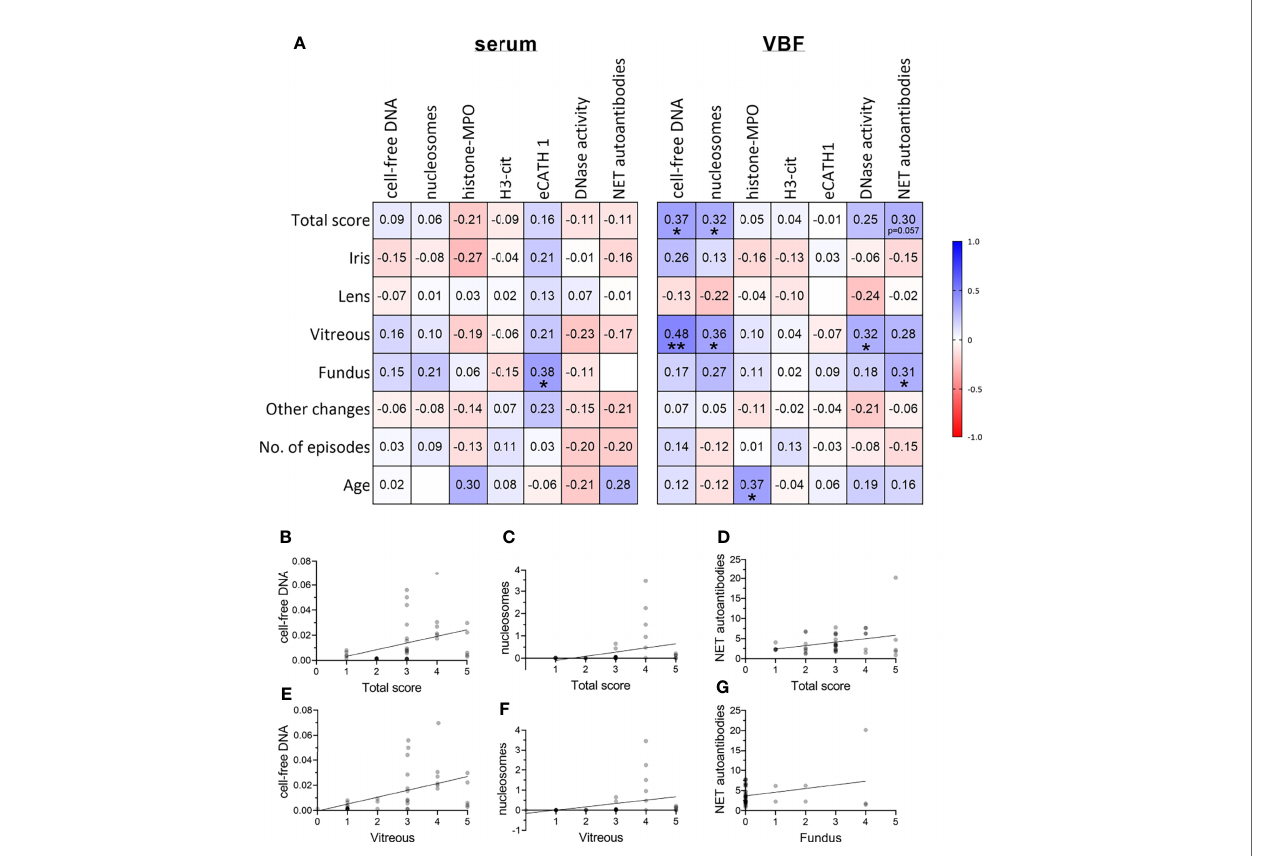
FIGURE 3 | Correlations between severity of ERU and occurrence of NET markers. (A) Correlations between ERU scores and NET markers in sera and vitreous body fl uids (VBF) of 40 horses with equine recurrent uveitis (ERU) were analysed. Signi fi cant correlations between cell-free DNA, nucleosomes, and DNase I activity in VBF with ERU severity were observed. The amount of NET autoantibodies correlated signi fi cantly with the fundus score and showed a strong tendency towards the total score ( p =0.057). A two-tailed Pearson correlation was performed. Pearson ’ s r values are presented, and p values are depicted if signi fi cant ( p values of * p < 0.05 and ** p < 0.01 were considered signi fi cant). (B – G) Scatter plots including the simple linear regression line of signi fi cantly correlating NET markers with the total or sub-scores or ERU severity are shown. Individual points are illustrated darker the more data points